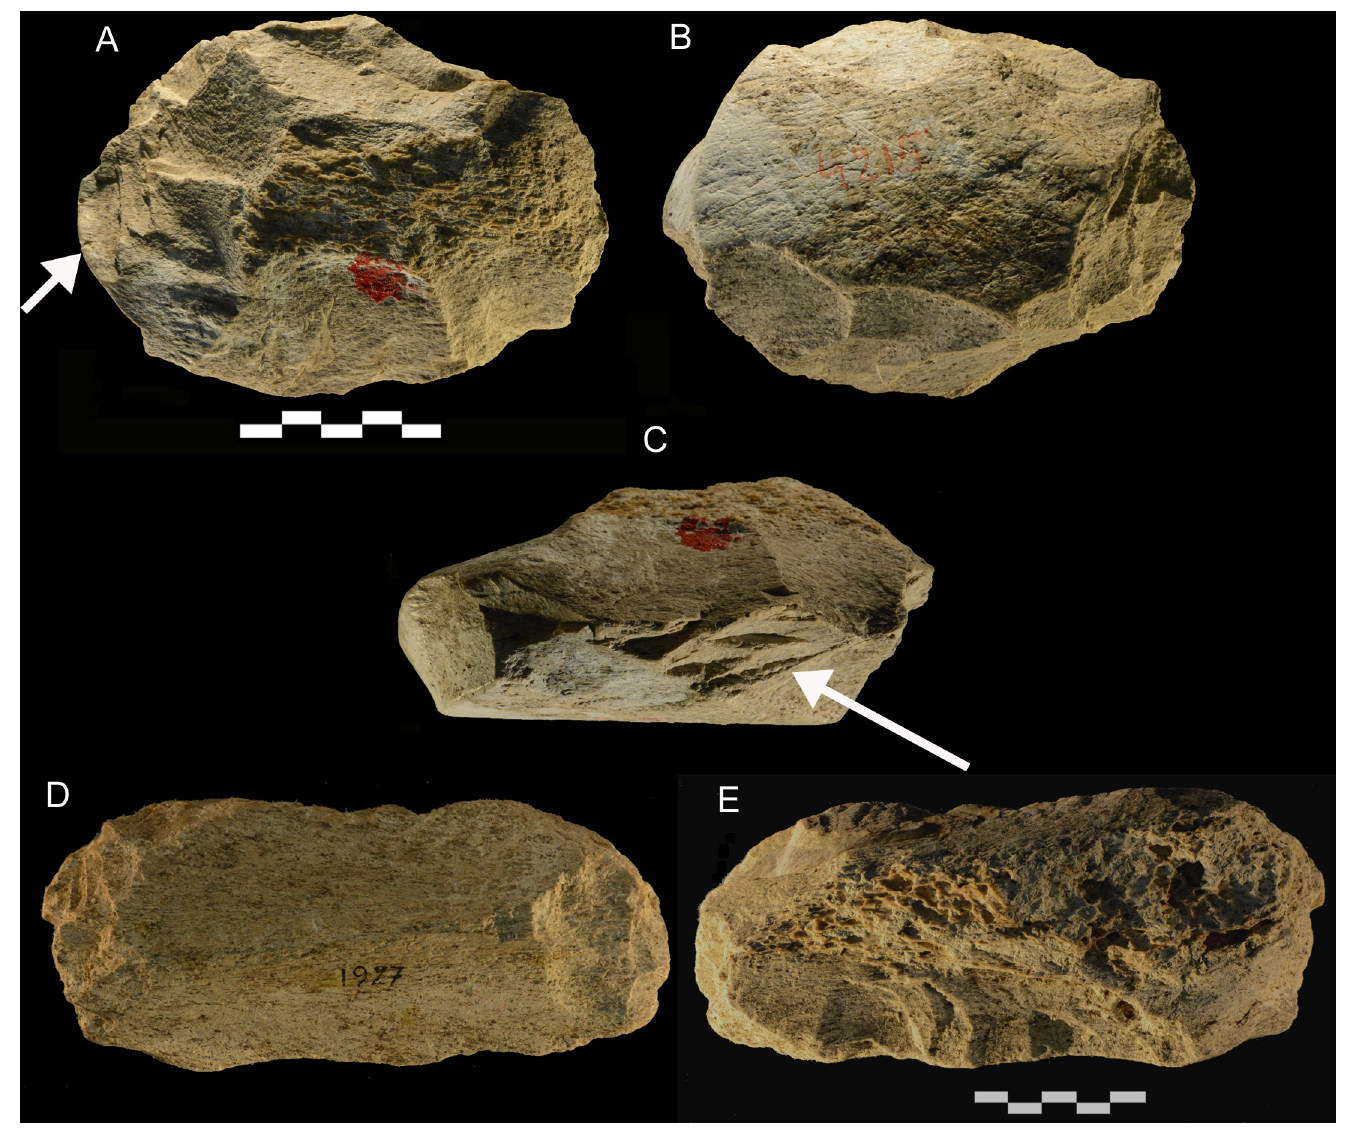
Fig 13. Castel di Guido. (A-C) Centripetal core with one heavily battered edge (arrow in C) and one edge (arrow in A) rounded and polished. (D, E) Intermediate piece with a lateral scraper edge. Both could be classed as tools with multiple uses.